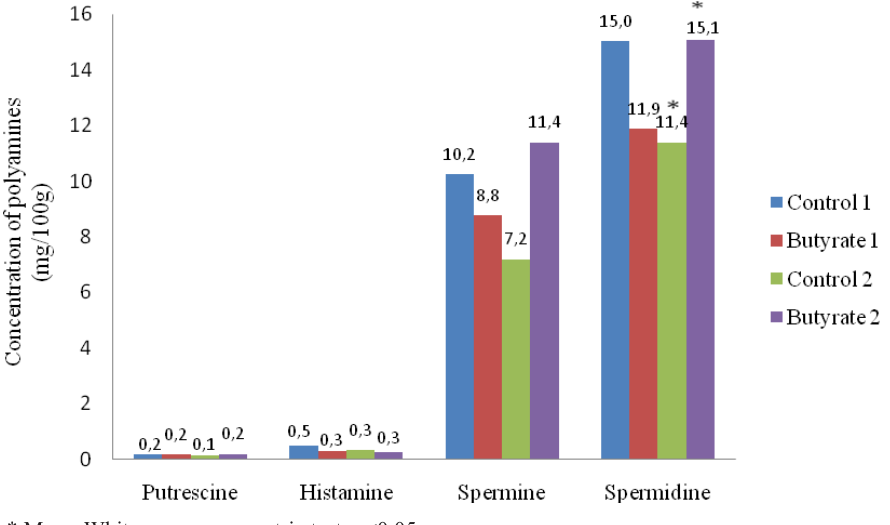
FIGURE 3 - Concentrations of polyamines in the large intestine (distal